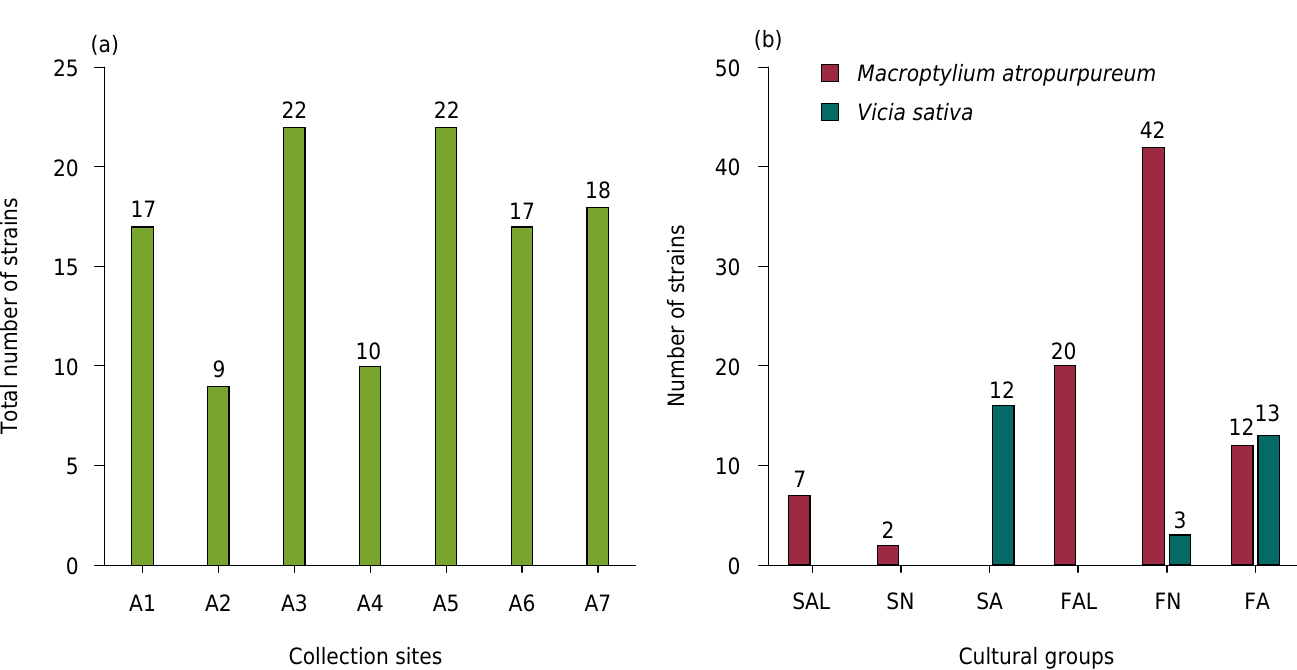
Figure 1. Number of isolated bacterial strains from coal-mined areas (a). Group distribution of the 115 isolates based on colony growth rate (time) and pH variation (b). SAL = slow growth, and alkaline pH; SN = slow growth and neutral pH; SA = slow growth and acid pH; FAL = fast growth and alkaline pH; FN = fast growth and neutral pH; FA = fast growth and acid